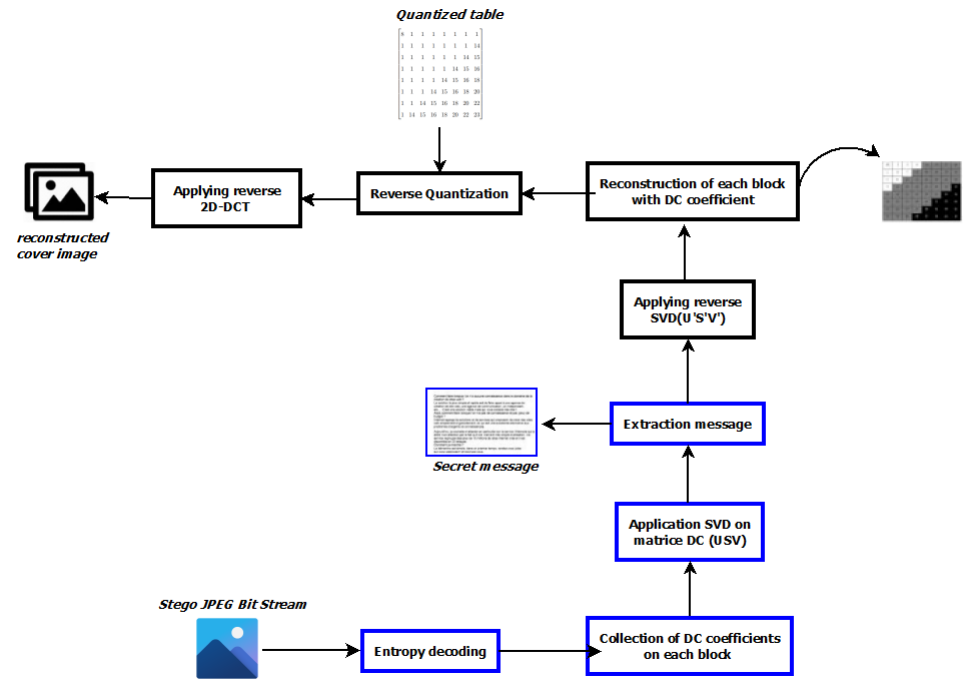
Figure 7: Extraction